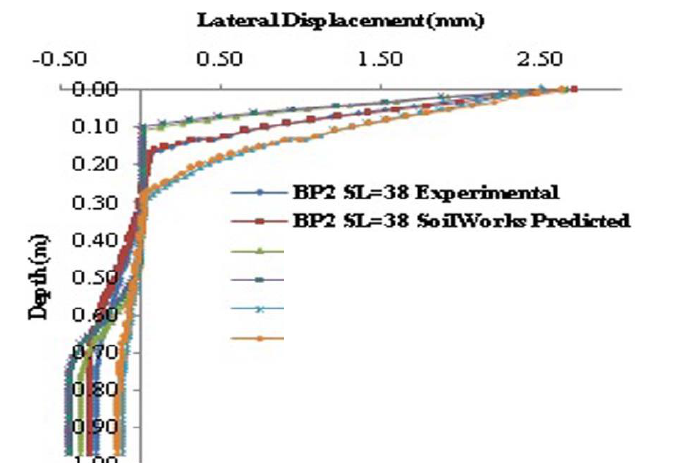
Fig. 13. Lateral displacements along the depth of bamboo pipe pile groups at 3D pile spacing in dense sand layer for slenderness ratio as 38 .